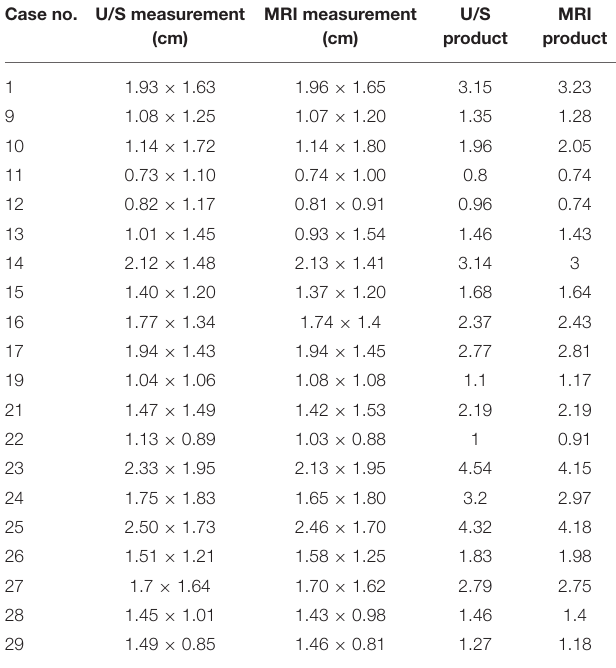
TABLE 2 | Measurement comparison of MRI and IOUS images for 20 canine